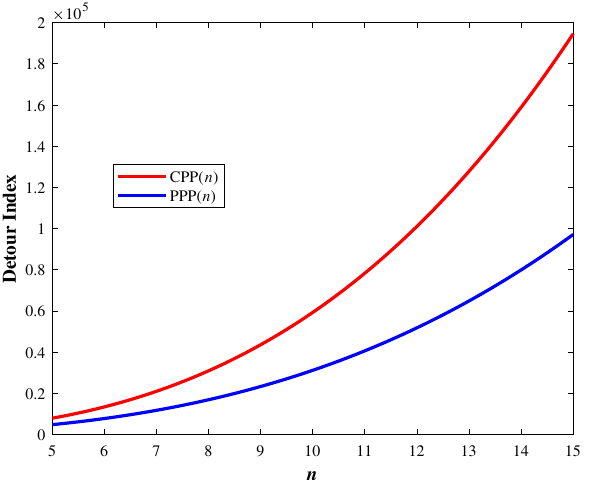
Figure 12. A comparative graphical representation of detour index of cycloparaphenylene CPP( n ) and poly ( p -phenylene) PPP( n